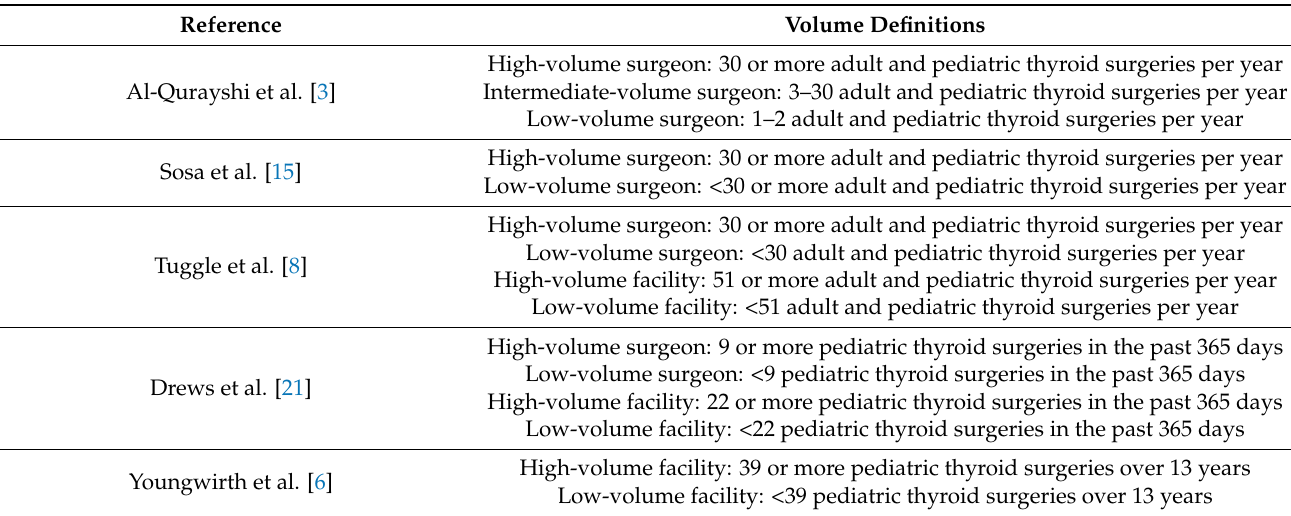
Table 3. What is a high-volume pediatric thyroid